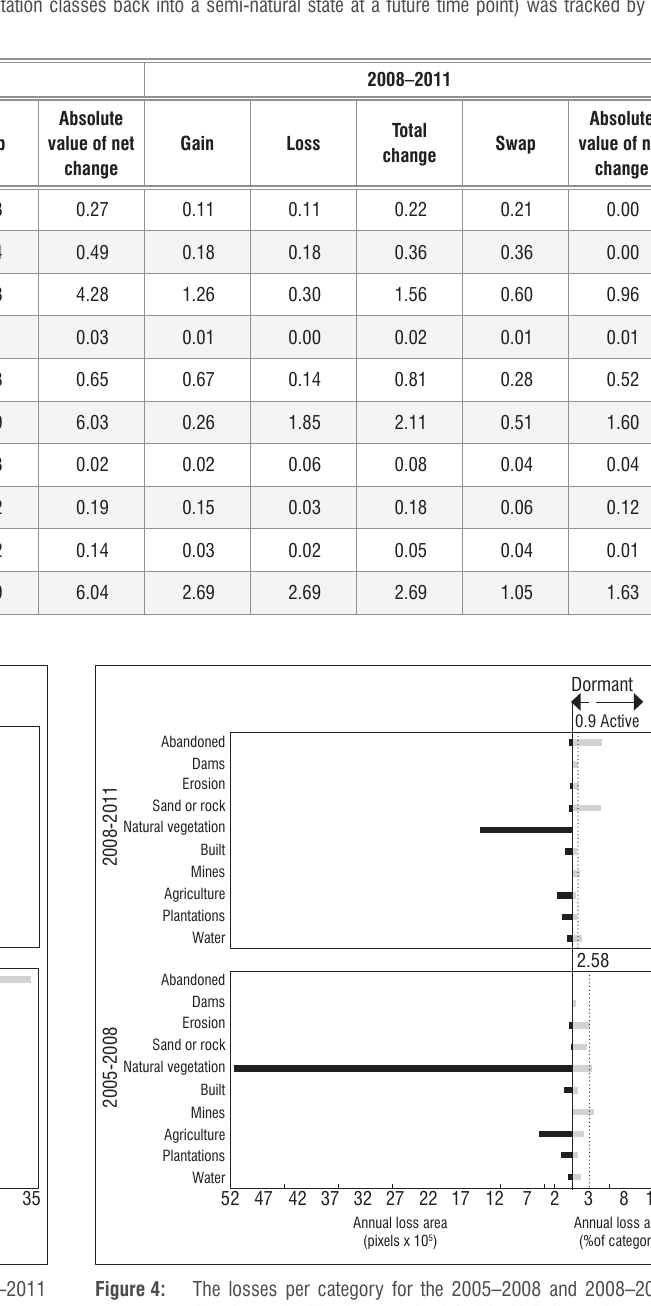
period. Examining the intensity of the category gains and losses, which also considers the size of the category concerned, reveals that dams, mines and erosion were actively gaining categories in both time periods. The number of dams in the province increased from approximately 14 455 in 2005 to over 20 980 in 2011, representing a 45% increase in the number and a 26% increase in the extent of dams. Mining extent increased by 90% and erosion by 44%. In terms of losses, plantations was consistently a dormant category. The water and sand/rock categories were dynamic in nature.